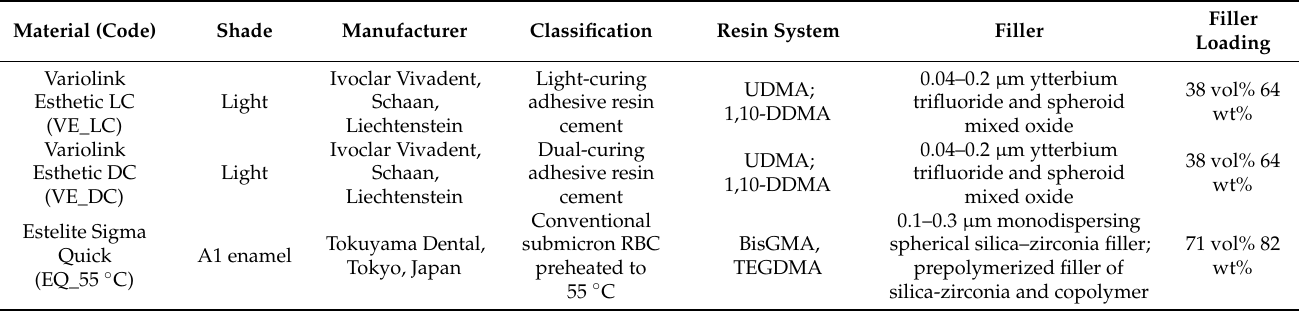
Table 1. Materials, manufacturers, classification, and composition of the investigated adhesive resin cements and preheated resin-based